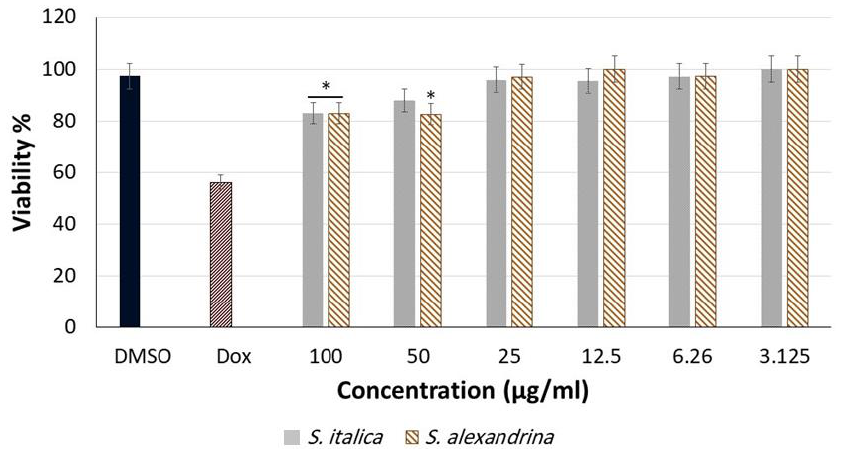
Figure 2. Viability of HepG2 cells after 48 h treatment with different concentrations (100 – 3.1 µg/mL) of the methanol extracts of S. italica and S. alexandrina . Doxorubicin (10 µg/mL) and DMSO (1%) were used as positive and negative controls, respectively. Analyses were carried out using the GraphPad Prism V.8 software and the one-way ANOVA test as well as Dunnett’s comparison test. The corresponding p -values marked with an asterisk are as follows: * < 0.05. The data are presented as mean ± SD ( n = 3).